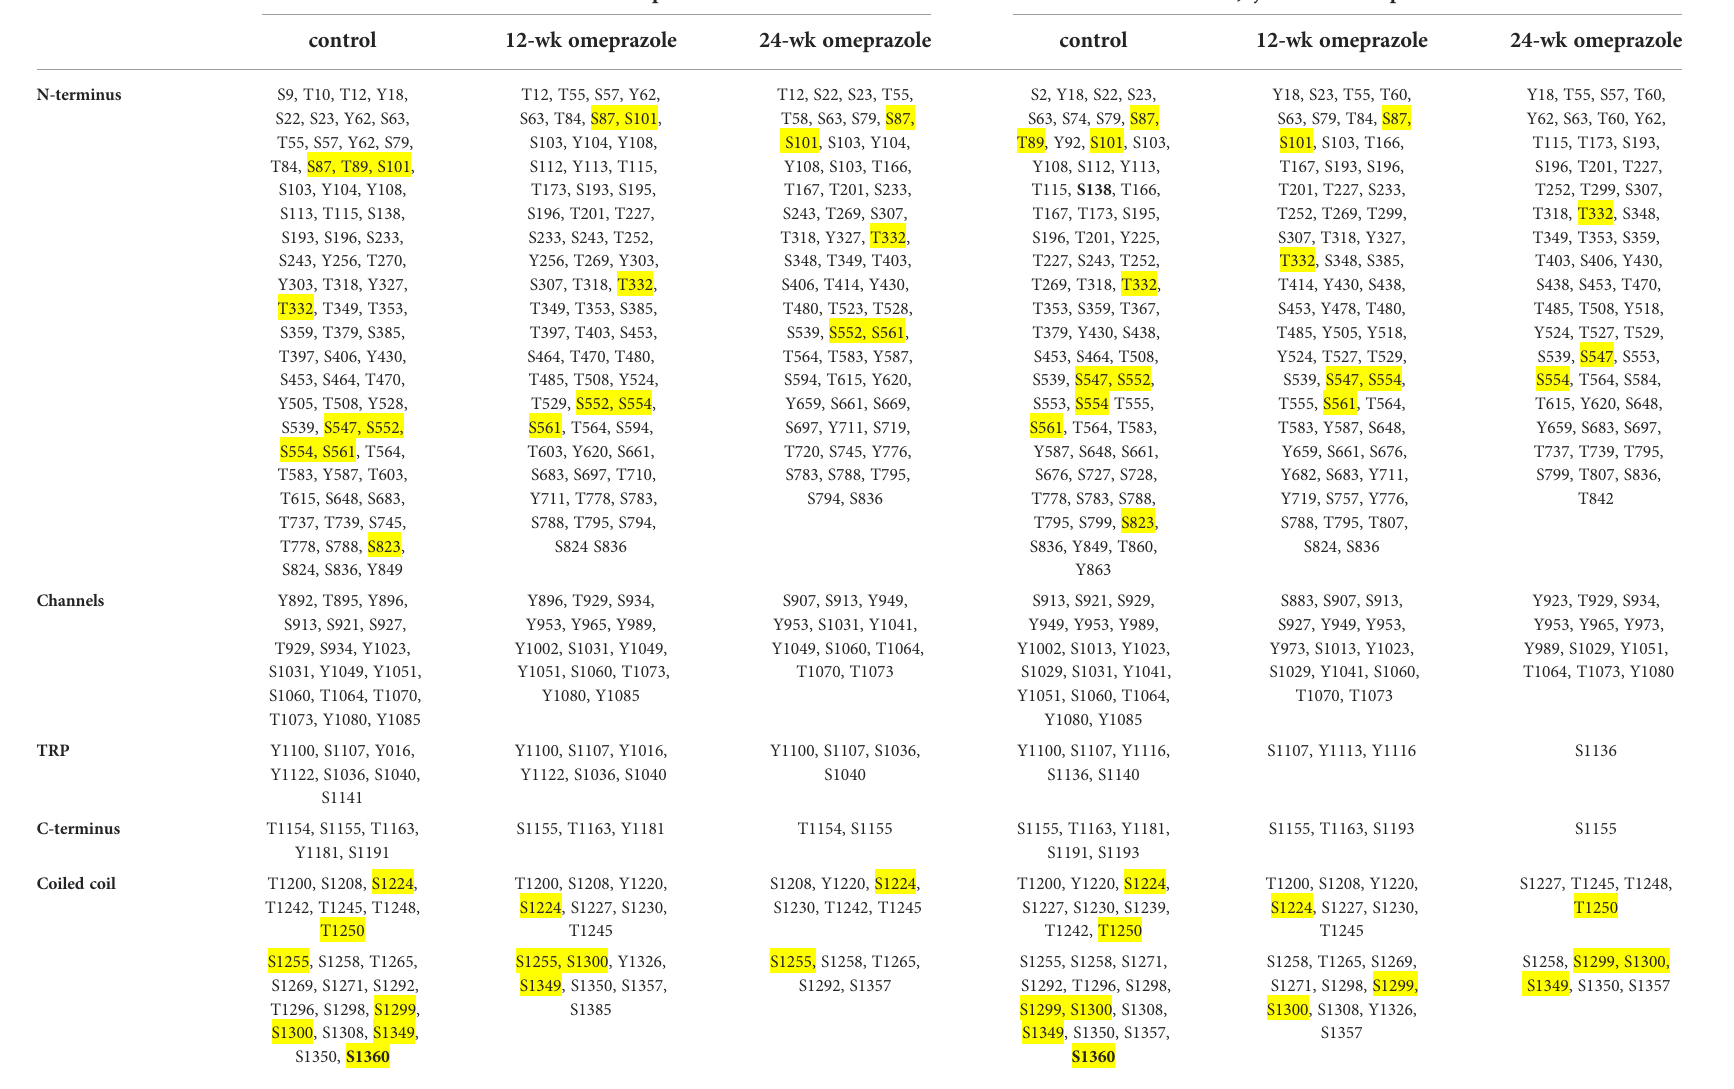
TABLE 2 Phosphorylated residue of TRPM7 protein from duodenum and jejunum of control or omeprazole-treated